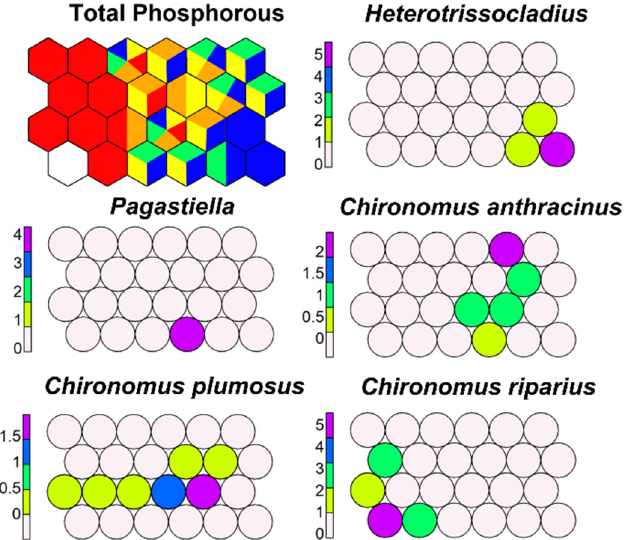
Figure 17. Supervised map of sites and five morphotaxa clustered using TP (in µg L − 1 ) as external variable. Blue, <10 µg L − 1 ; green, 10–20 µg L − 1 ; yellow, 20–30 µg L − 1 ; orange, 30–50 µg L − 1 ; red, >50 µg L − 1 .